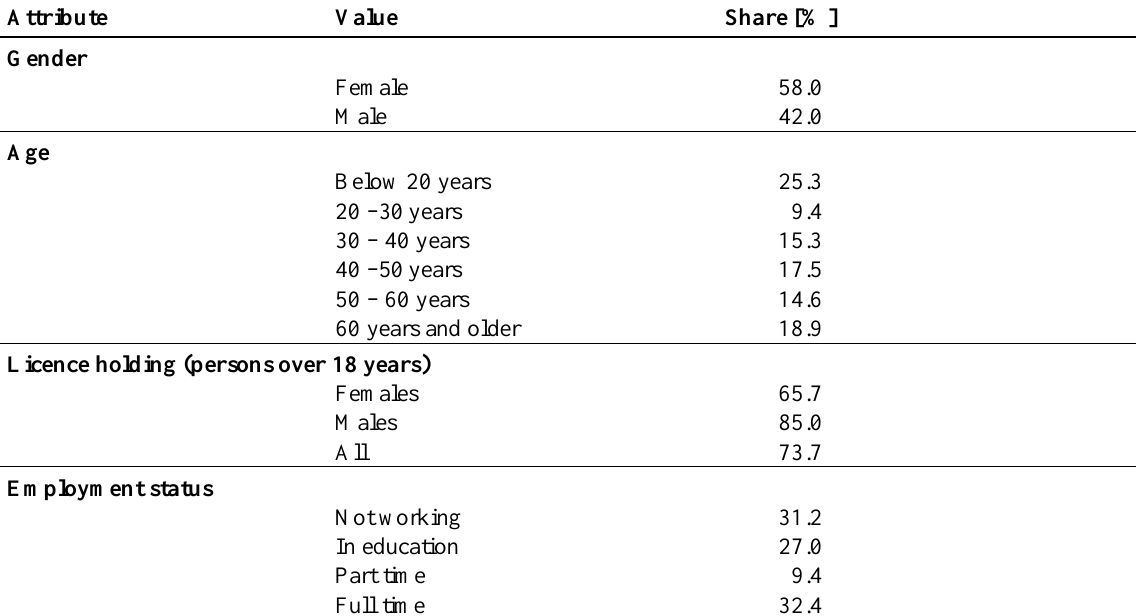
Table 2. Socio-demographic characteristics of the mobile panel members